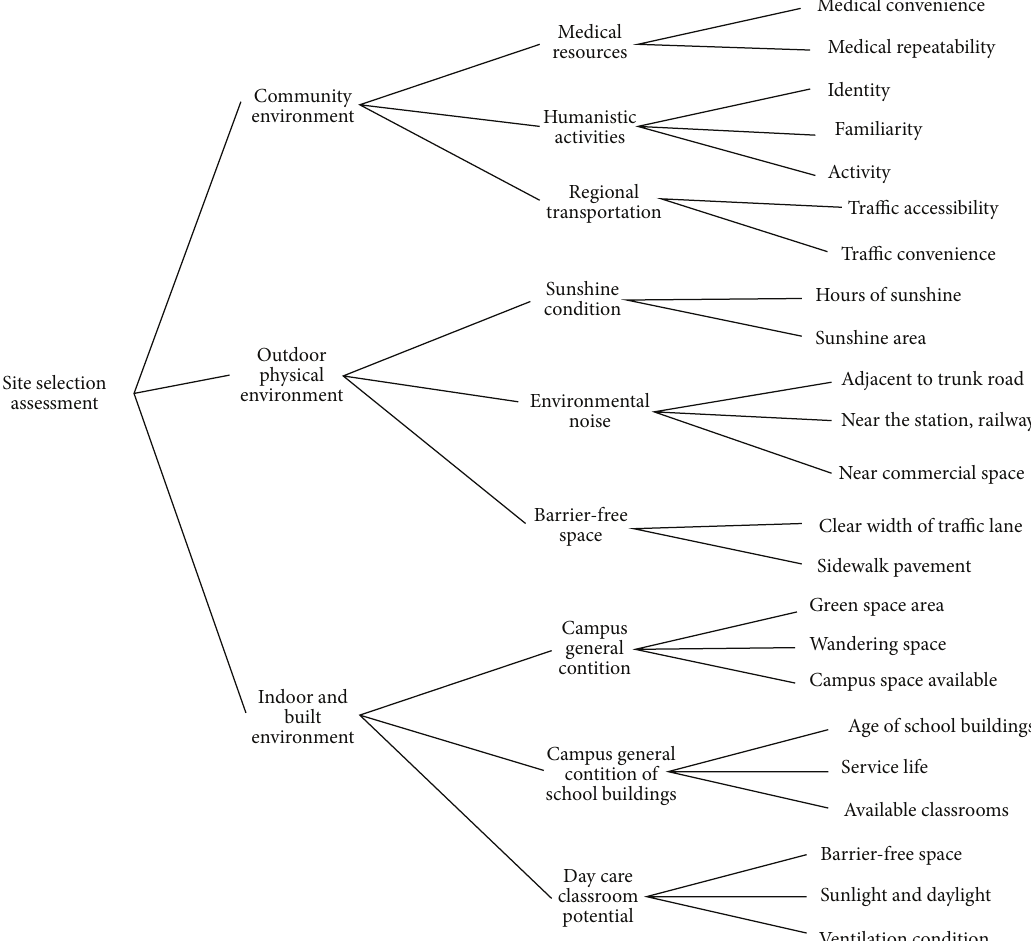
Figure 1. Dimension, factors and indicators for site selection